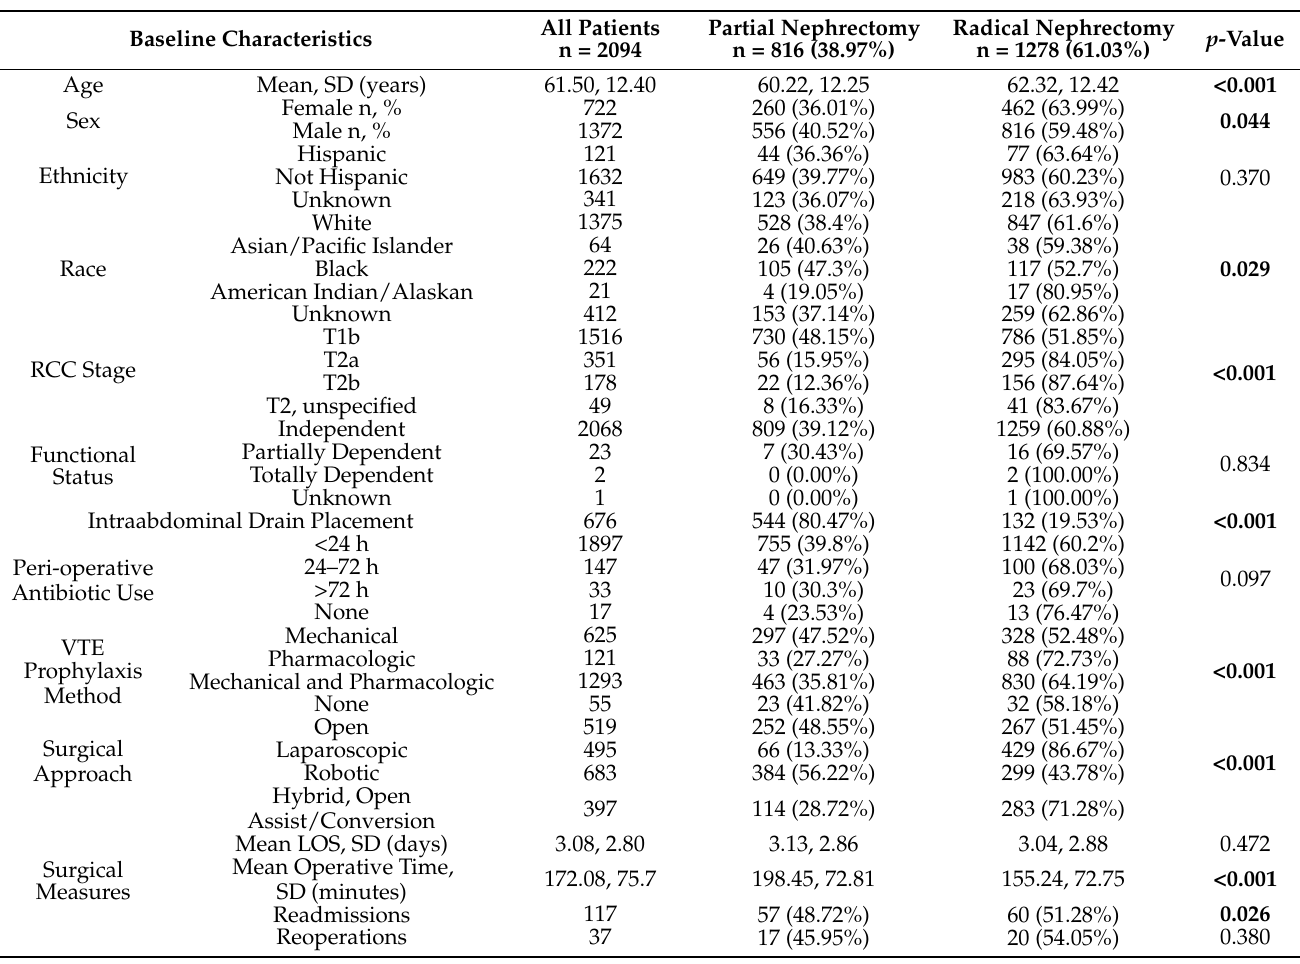
Table 1. Patient characteristics stratified by partial versus radical nephrectomy for renal cell carcinoma. Baseline